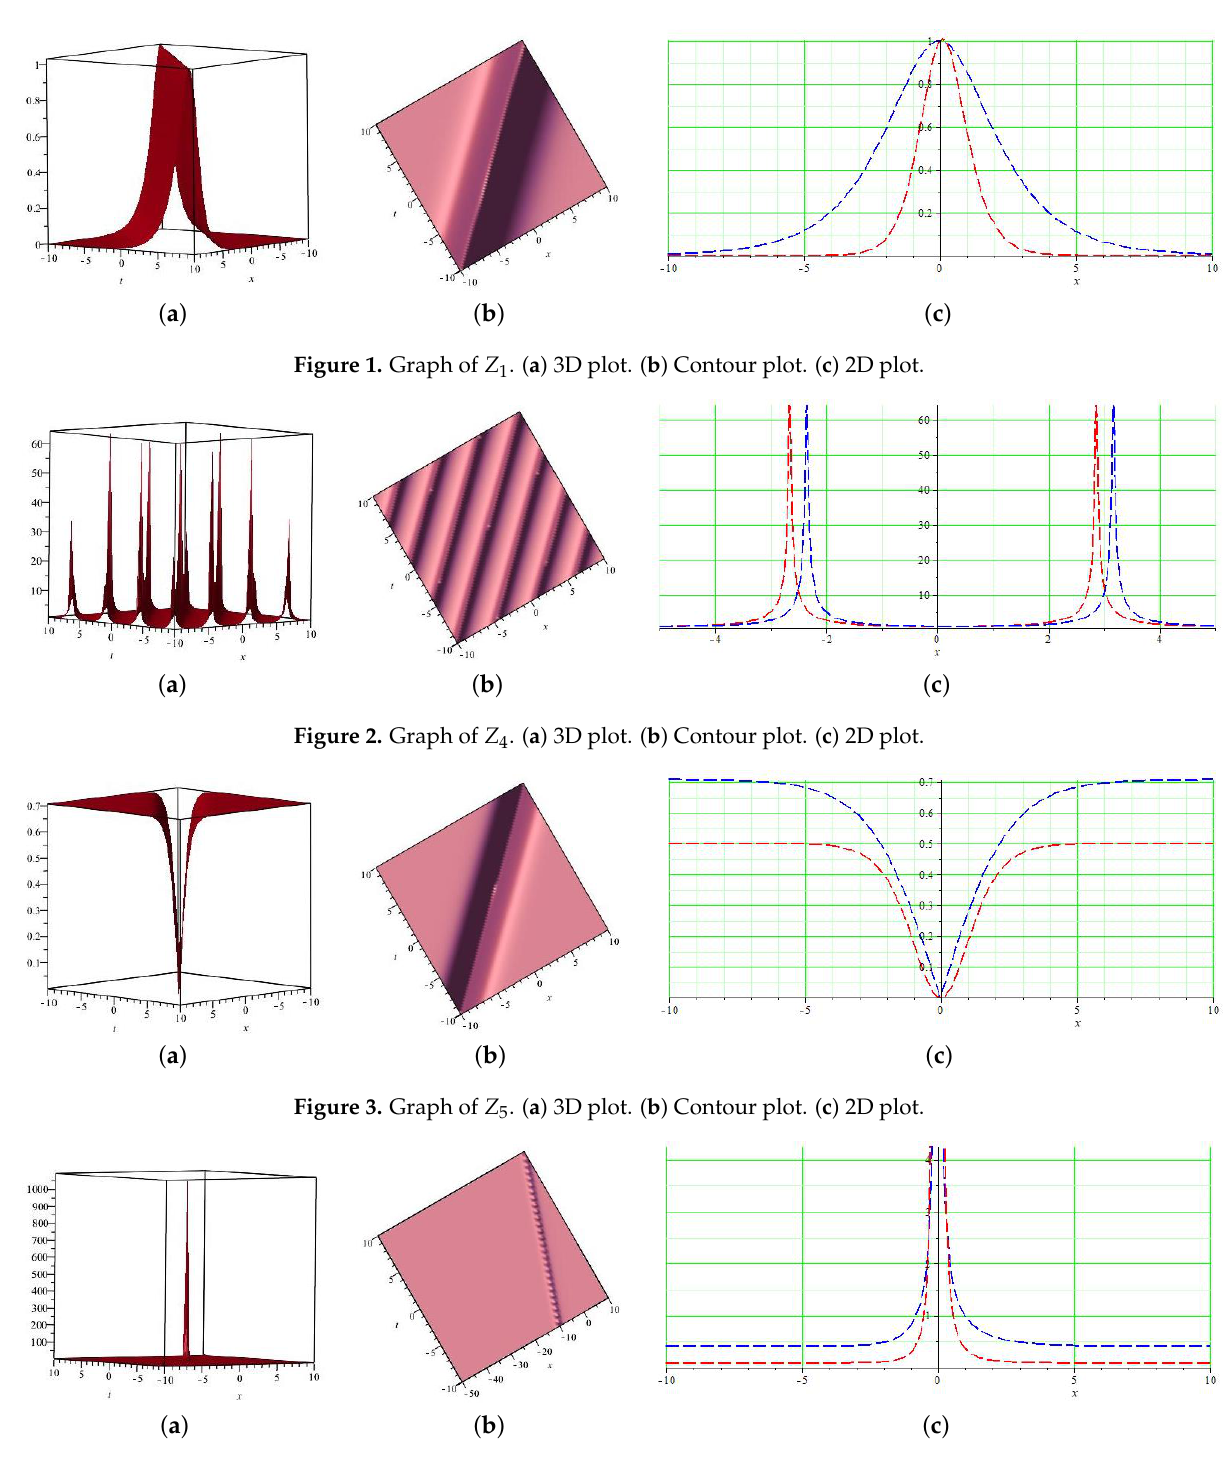
Figure 4. Graph of Z 6 . ( a ) 3D plot. ( b ) Contour plot. ( c ) 2D